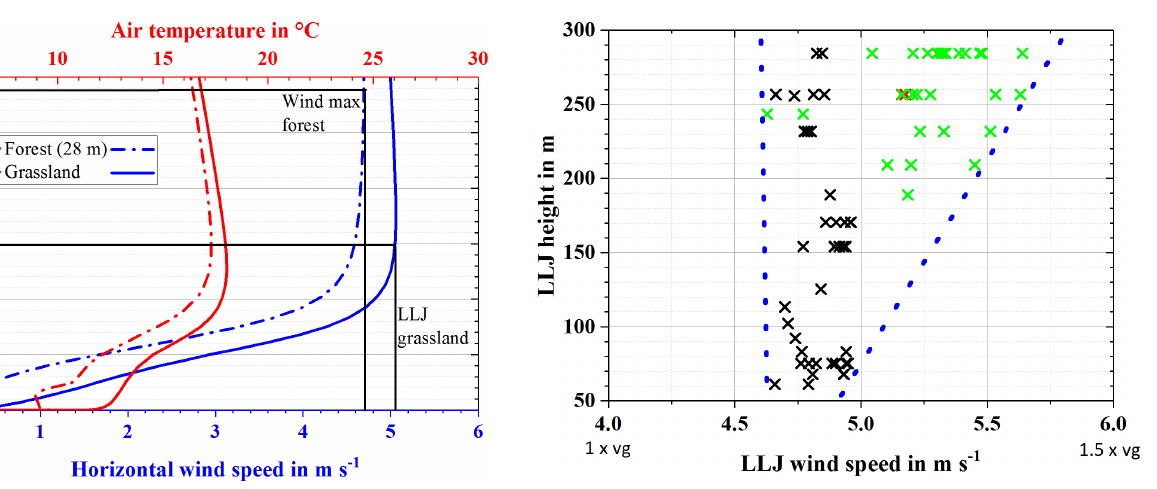
Figure 4. Vertical profiles of wind speed (blue) and air temperature (red) above a grassland (solid line) and a deciduous forest site (dot- dashed line, PAD profile see Fig. 1) at 04:00LT, cloudless summer day (19 June), vg = 4ms − 1 .